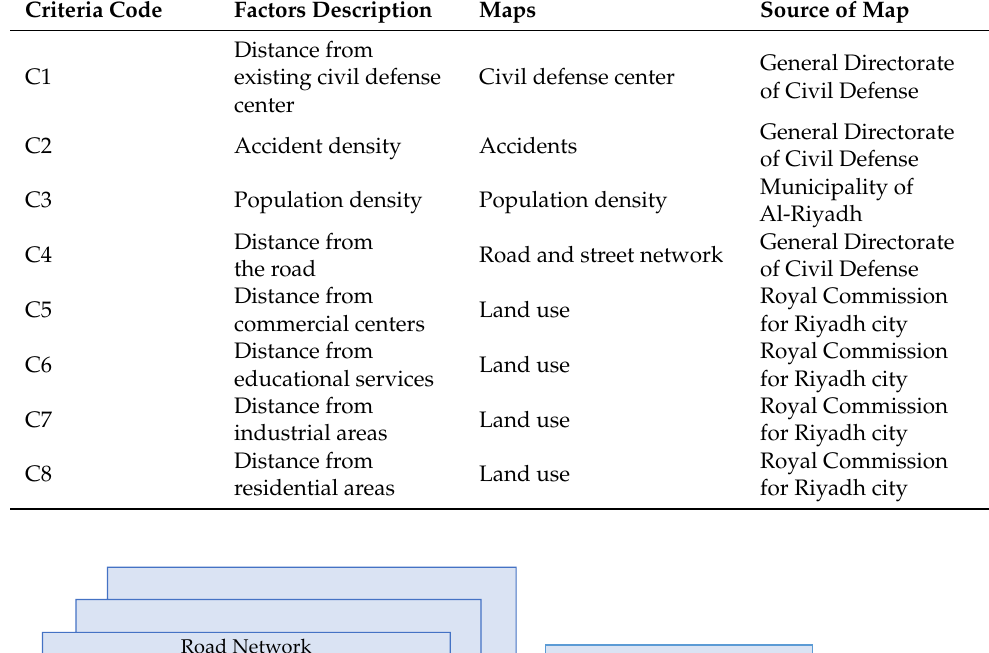
Table 2. Coding criteria and data sources of the prediction-factor layers.